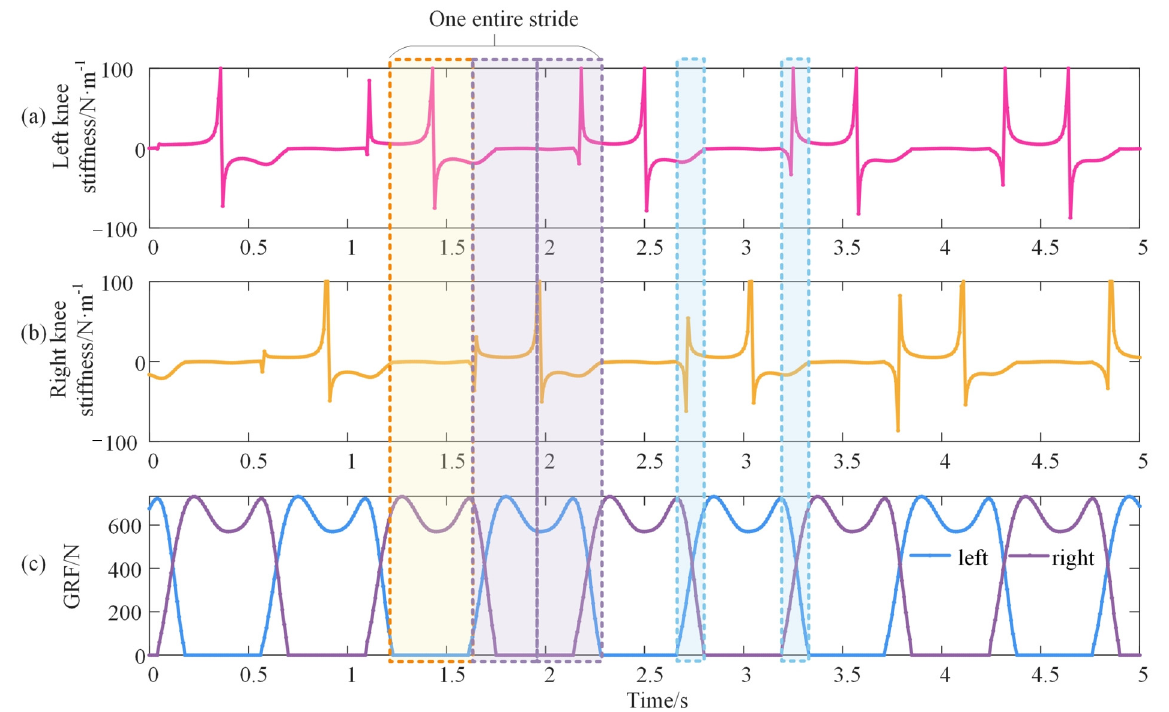
Figure 8. Vertical stiffness of the knee during walking. ( a , b ) denote the left and right knees, respec- tively, and ( c ) is the corresponding vertical GRF. The yellow rectangle shows the loading response phase to the terminal stance phase of the right leg and the mid-swing phase of the left leg. The purple rectangle represents the terminal stance phase to the loading response phase and is equally separated by the mid-swing phase of the right leg as well as the stance phase of the left leg. The blue rectangles are the double support phase.